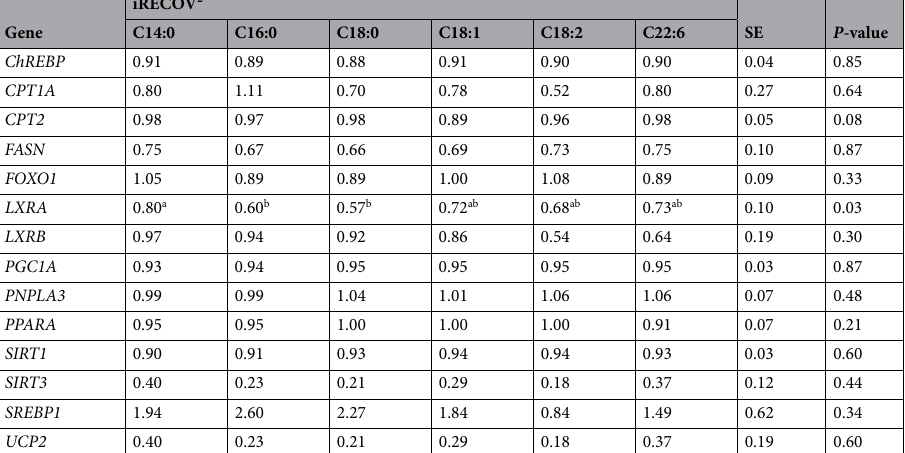
Table 2. Least squares means and standard error of the means (SE) of the gene expression of genes of interest in primary bovine hepatocytes treated with individual fatty acids physiologically found circulating in dairy cows at an in vivo mixture at 0.5 mM 1 during liver lipid clearing (iRECOV) with significant differences between means denoted with different superscript letters. 1 Concentratoin of C14:0, C16:0, C18:0, C18:1 n-9, C18:2 n-6, and C22:6 n-3 was treated at 0.009, 0.175, 0.279, 0.021, and 0.011 mM, respectively. 2 C14:0,